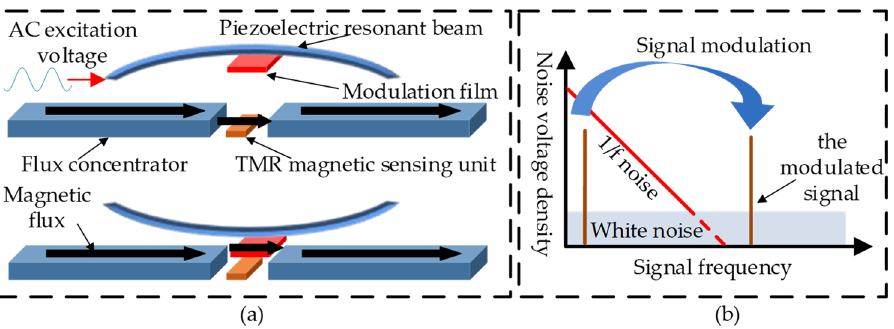
Figure 1. Magnetic flux vertical modulation based on piezoelectric resonance: ( a ) flux vertical modulation principle based on piezoelectric resonance; ( b ) noise suppression by modulation.